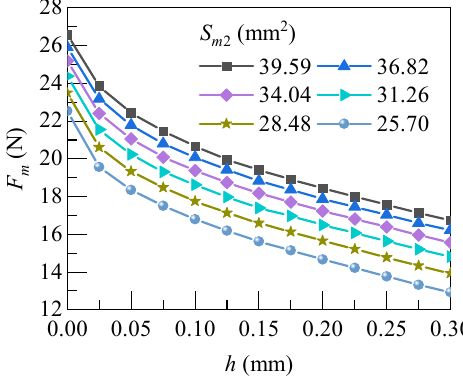
Figure 10. Static electromagnetic force varies with S m 2 .